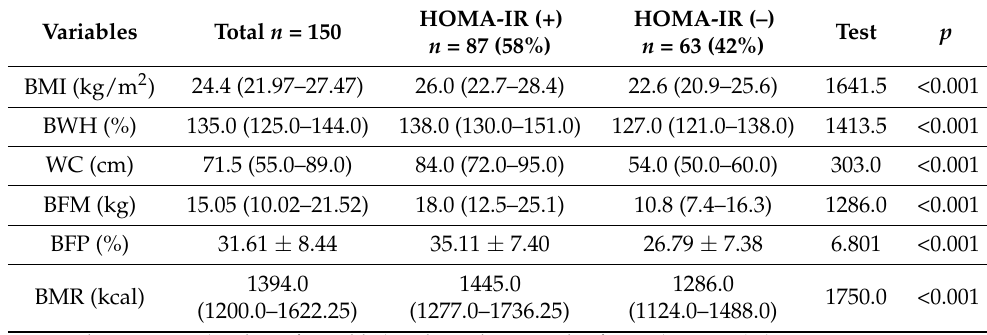
Table 2. Comparison of the anthropometric characteristics of the two groups.